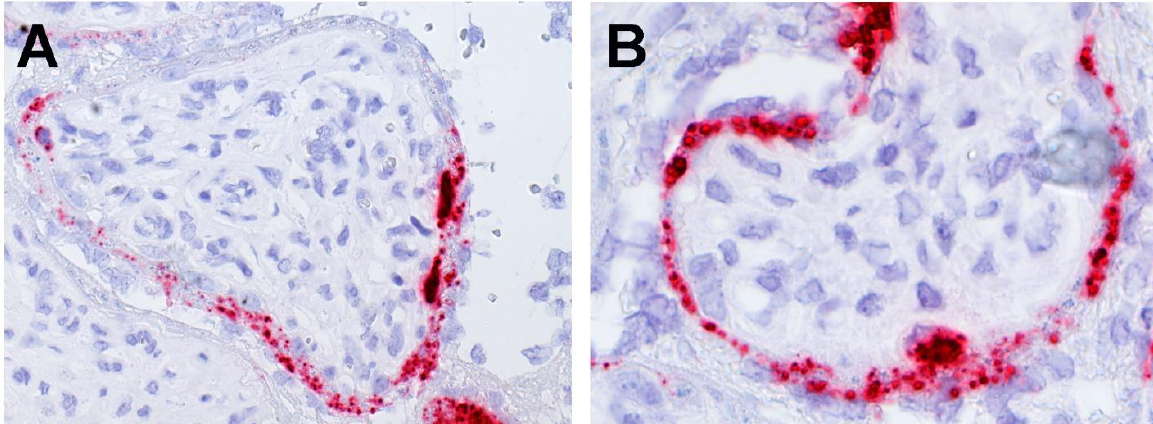
Figure 9. A,B. Large cells immediately beneath the syncytiotrophoblast layer that are morphologically consistent with cytotrophoblast show strong positive staining using RNAscope for SARS-CoV-2 spike protein mRNA. The syncytiotrophoblast also stains positive, but not as intensely. ( A ), ×20; ( B ), ×40.